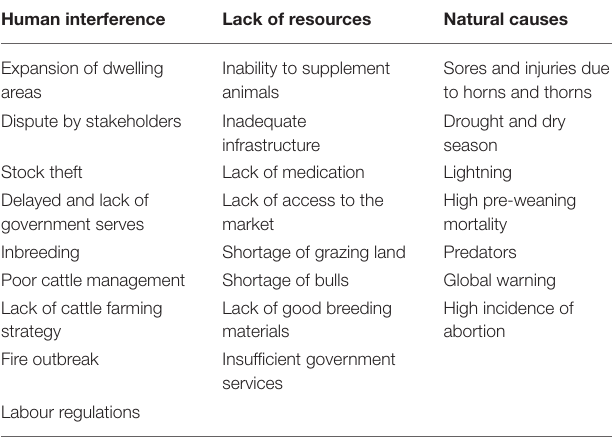
TABLE 9 | Challenges to the accessibility of reproductive technologies by low-income beef farmers in South Africa. Human